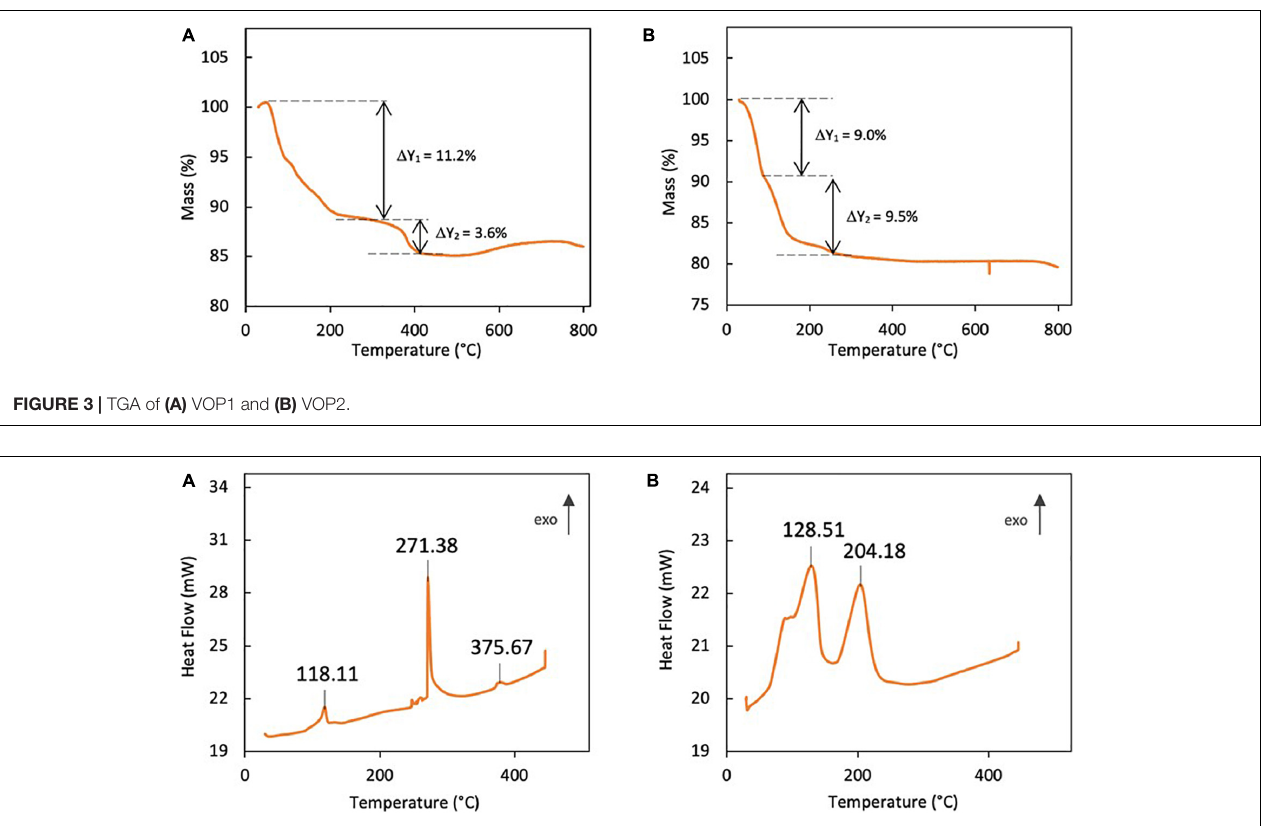
FIGURE 4 | DSC of (A) VOP1 and (B)